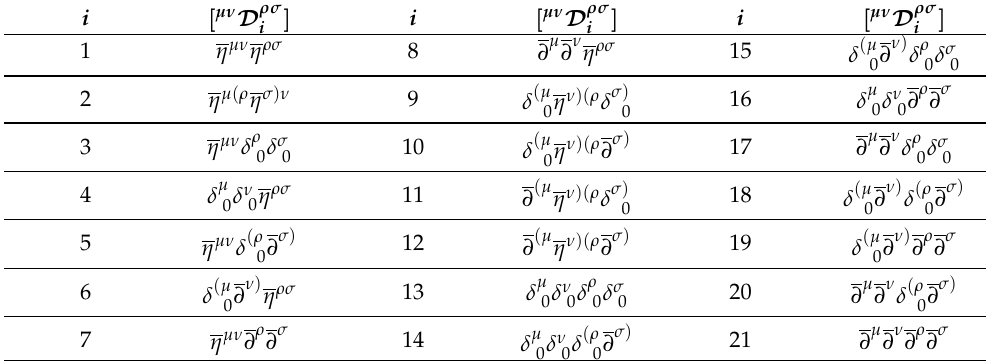
Table 1. The 21 basis tensors used in Expression (11). The pairs ( 3,4 ) , ( 5,6 ) , ( 7,8 ) , ( 10,11 ) , ( 14,15 ) , ( 16,17 ) , and ( 19,20 ) are related by reflection.